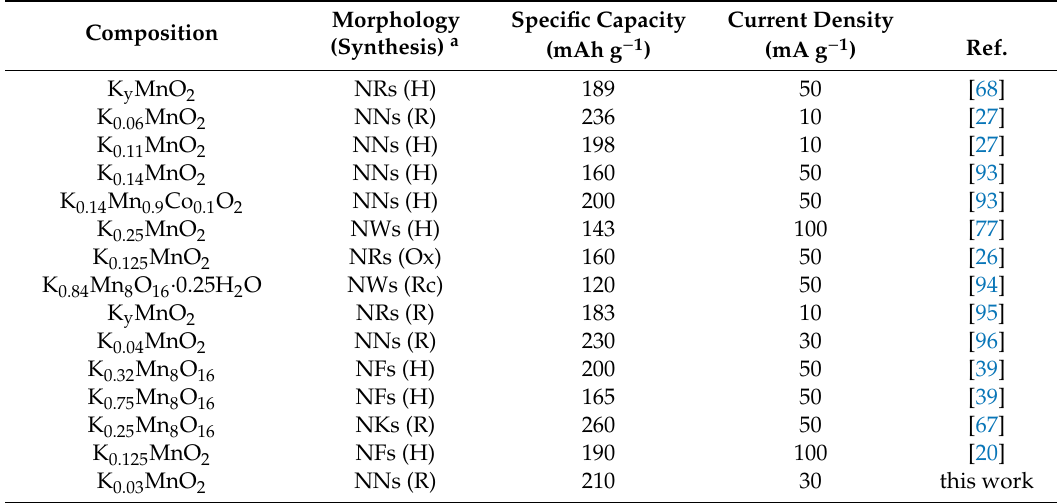
Table 1. Comparison of electrochemical performance of cryptomelane-type α -K y MnO 2 cathode